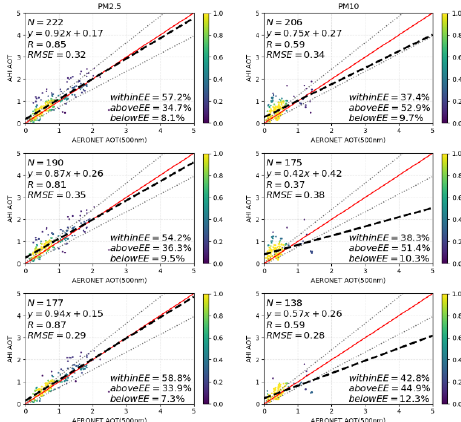
Figure 6. Scatter plots of comparing the AHI hourly AOTs and ground AOT under the different primary pollutants condition